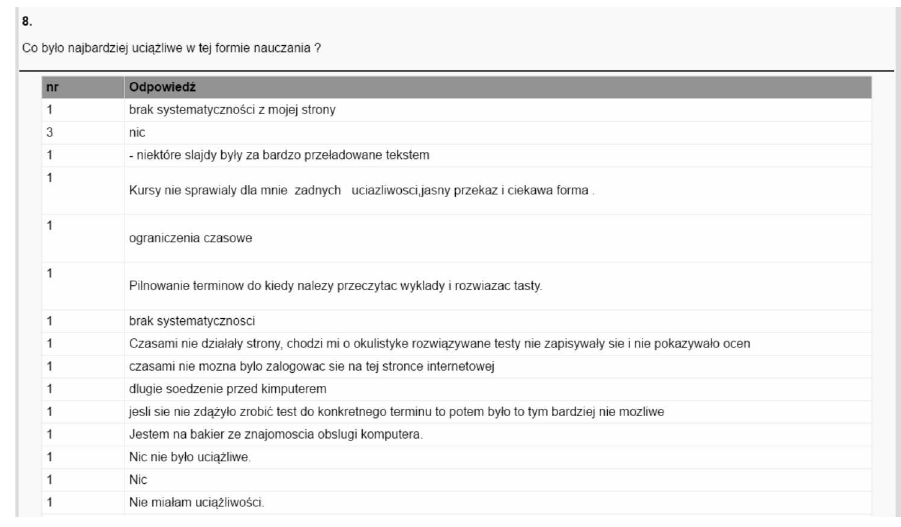
Figure 7. Examples of students’ responses to the question: “What was the most burdensome in this form of learning?”